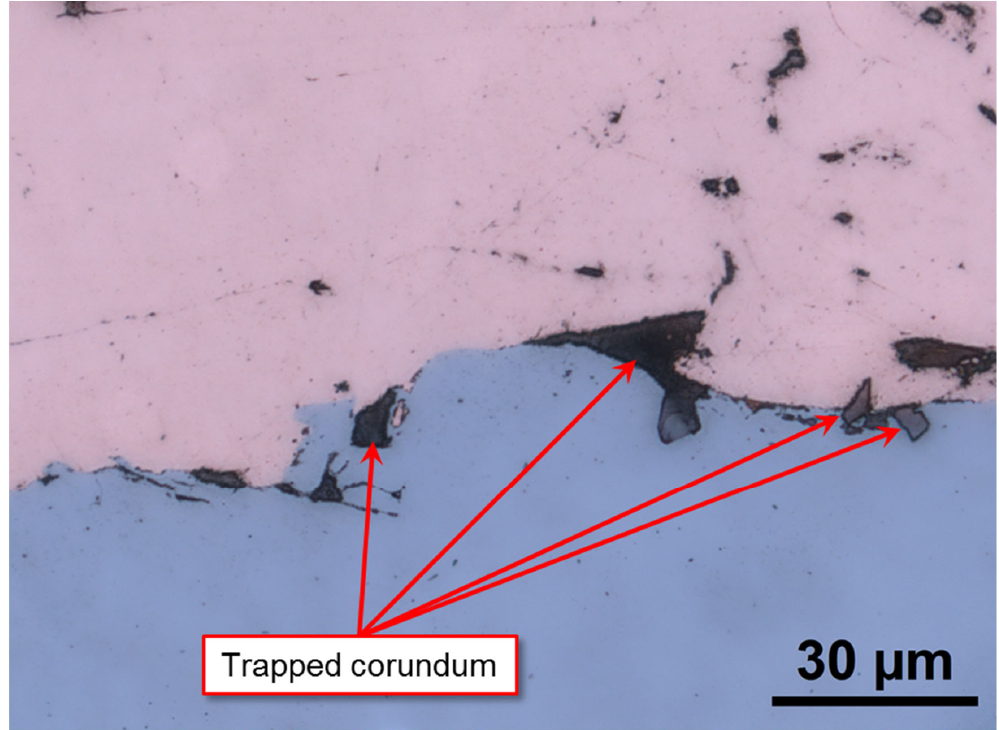
Figure 15. Reflected light microscopy image of a cross section of a copper coating, blasted and coated in the chamber, revealing trapped corundum particles at the interface.